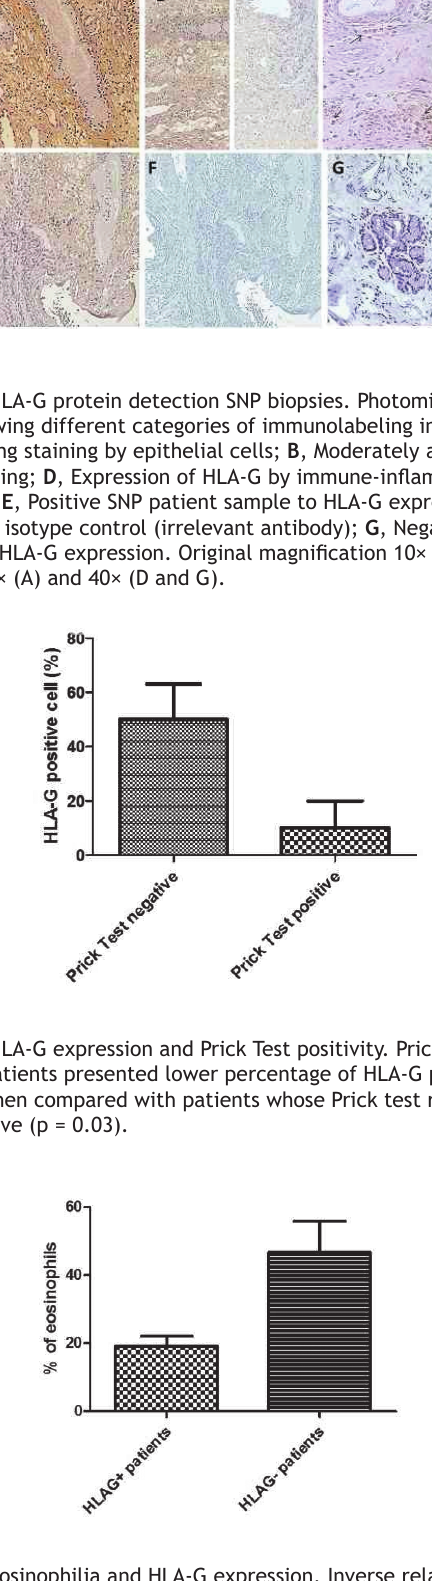
Figure 3 Eosinophilia and HLA-G expression. Inverse rela- tionship between eosinophilia and expression of HLA-G. HLA-G positive patients presented lower eosinophilia (Mann Whitney test, p = 0.0330; Spearmen correlation r, p = 0.0126).